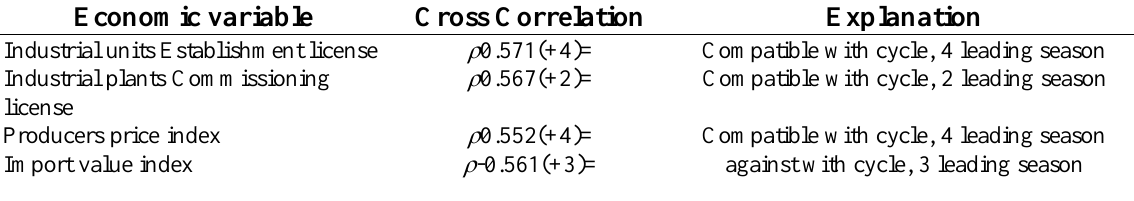
Table 2. Correlation of components variables and referred